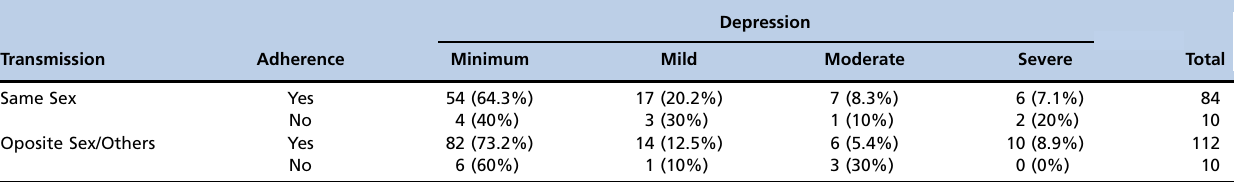
Table 4 - Chances of individual develop depression in the studied group. Observed distribution of depression per transmission and